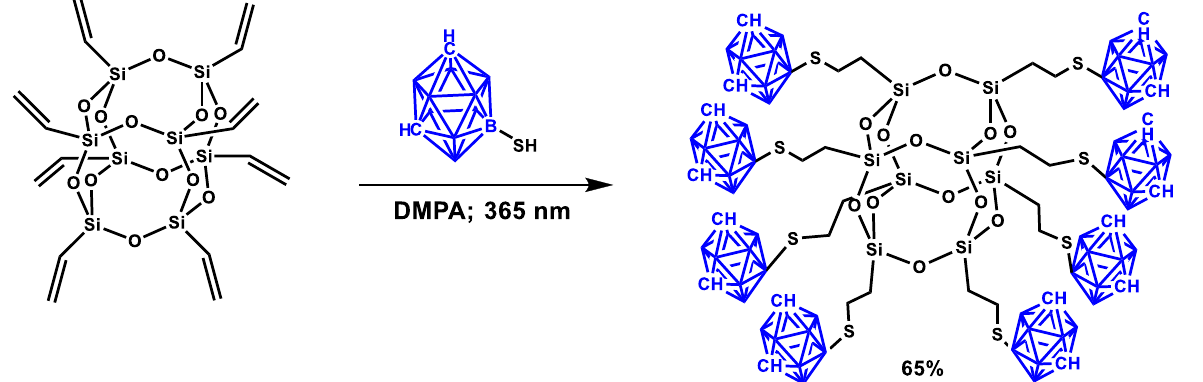
Figure 23. The scheme of synthesizing a carborane-containing POSS by thiol-ene addition. from Ref.